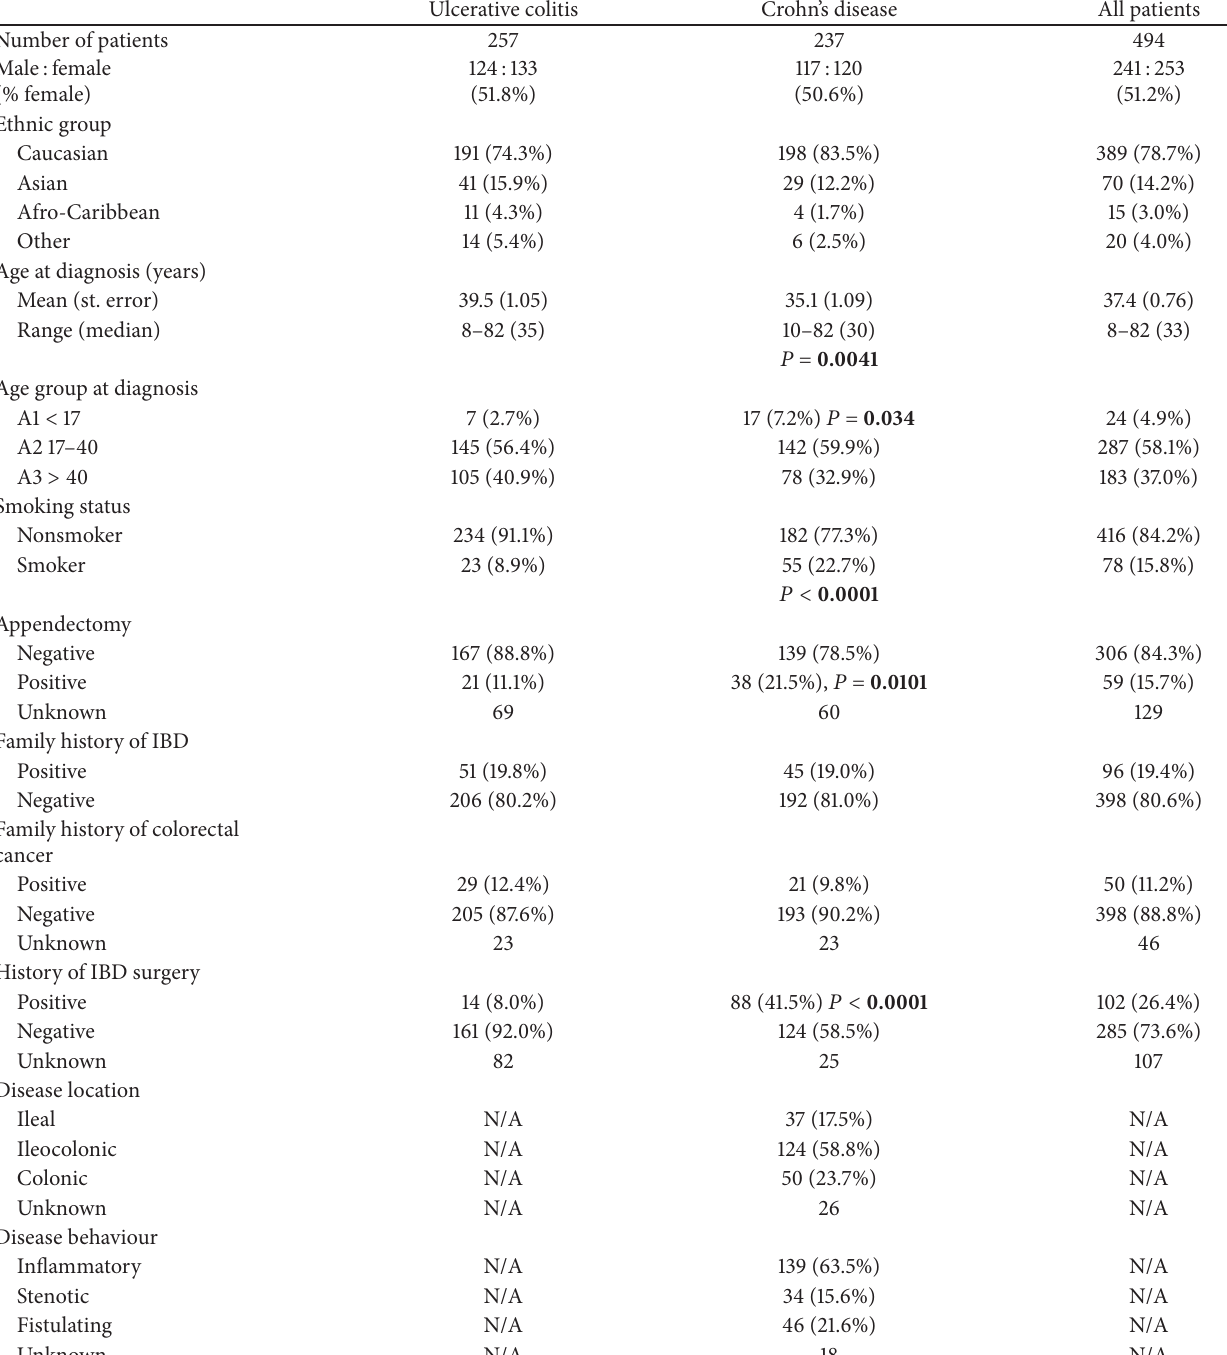
Table 1: Disease characteristics of study